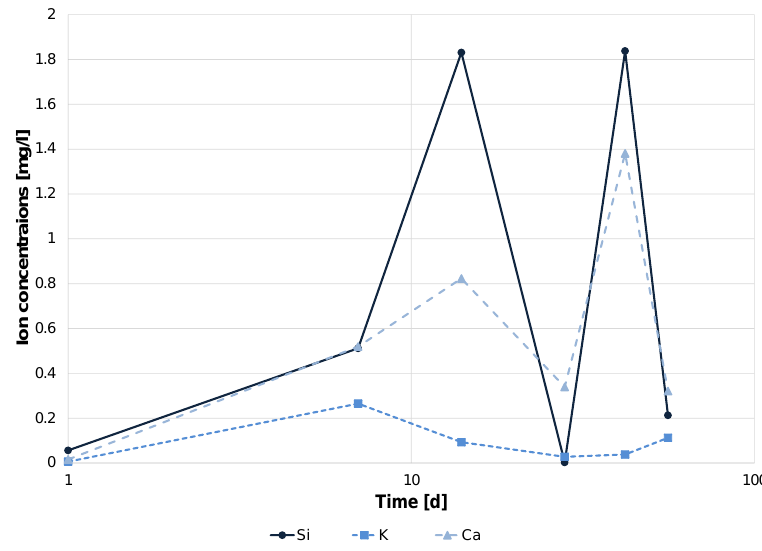
Figure 6. Ion concentration in deionised H 2 O in relation to time for glass 18-06. The concentration of the different ions for glass 1-06 in dependence of the storage time can be seen in Figure 7.